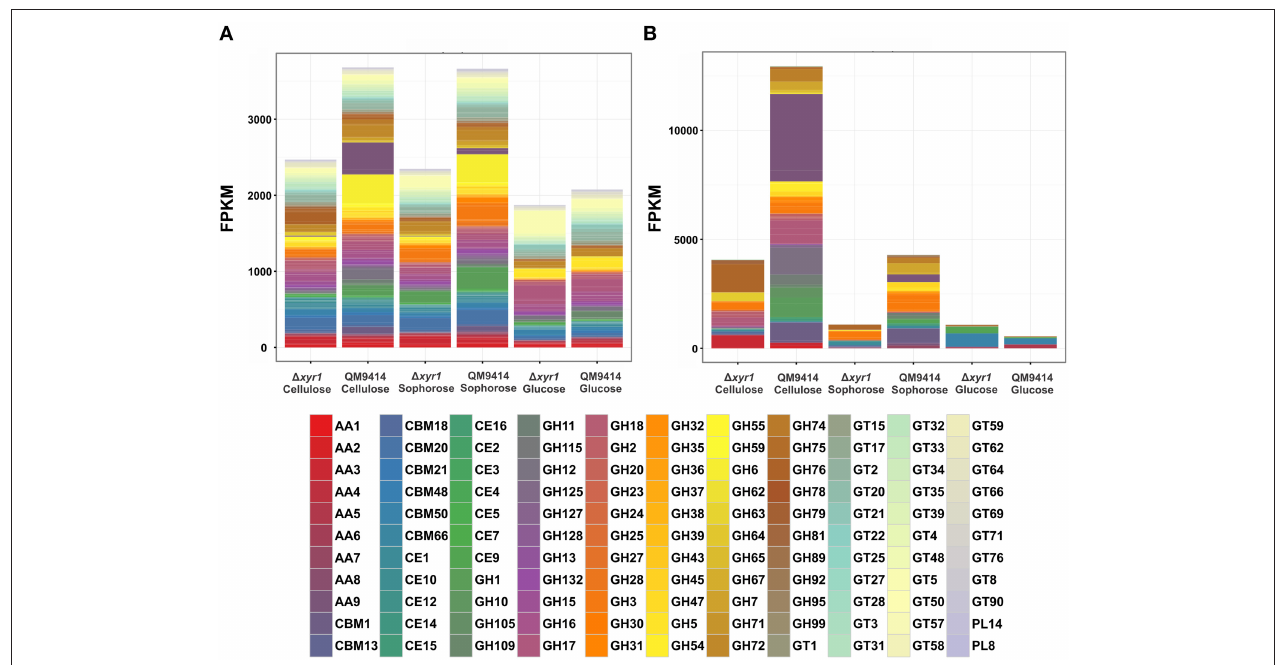
FIGURE 4 | Gene expression profiles of Carbohydrate Active enZymes (CAZy) of the ∆ xyr1 strain compared to parental strain QM9414. Fragments per kilobase of exon per million fragments mapped (FPKM) for each enzyme class cultured in presence of glucose, cellulose, and sophorose. (A) All CAZymes identified in this study; (B) Only the differentially expressed CAZymes of each carbon source were used in this analysis. AA, Auxiliary Activities—redox enzymes that act in conjunction with CAZymes; CBM, Carbohydrate-Binding Modules—adhesion to carbohydrates; CE, Carbohydrate Esterases—hydrolysis of carbohydrate esters; GH, Glycoside Hydrolases—hydrolysis and/or rearrangement of glycosidic bonds; GT, GlycosylTransferases—formation of glycosidic bonds; PL, Polysaccharide Lyases—non-hydrolytic cleavage of glycosidic